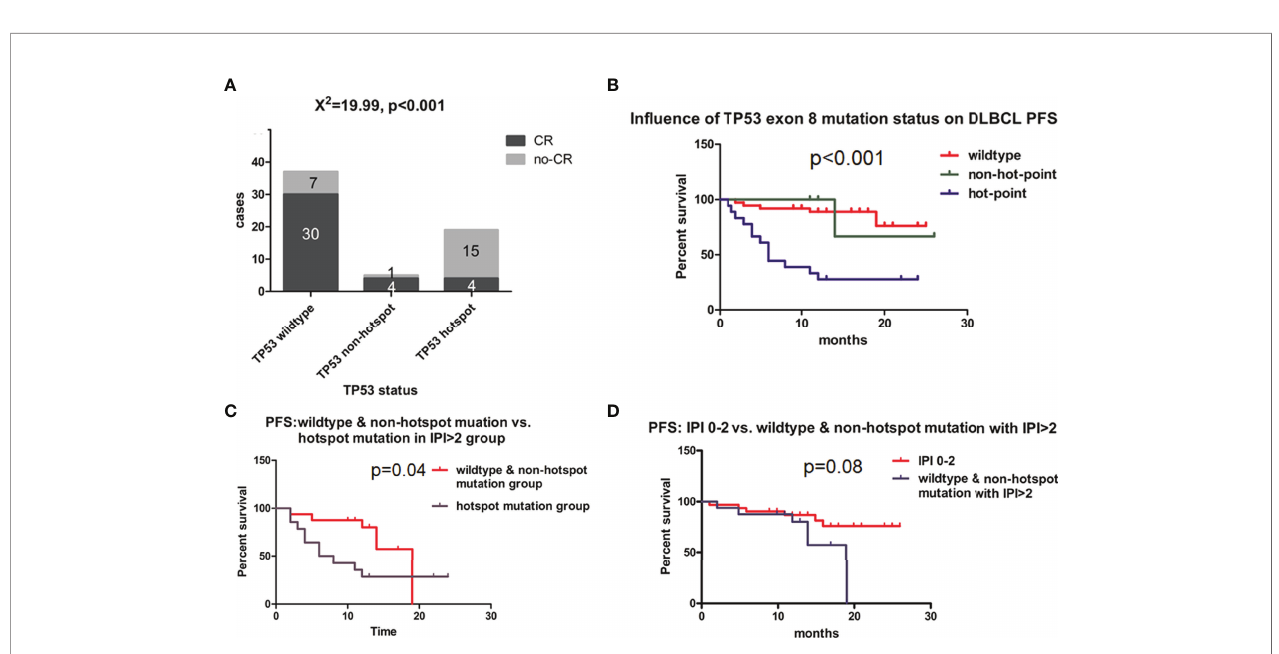
FIGURE 3 | Effect of TP53 exon 8 mutation on the clinical outcome of DLBCL patients. (A) CR rates in different groups based on TP53 status. CR status was evaluated by positron emission tomography – computed tomography scanning according to Lugano response criteria for non-Hodgkin ’ s lymphoma. Differences between groups of patients were assessed with the maximum likelihood chi-squared test. (B) PFS of different TP53 status groups. (C) PFS of IPI >2 group; patients with TP53 hotspot mutations, wild-type TP53 , and non-hotspot TP53 mutations were compared. (D) Comparison of PFS between IPI 0 – 2 and IPI >2 groups with wild-type TP53 and non-hotspot TP53 mutations. Patients were followed up for 12 months until disease progression, relapse, or end of observation. PFS was de fi ned as time to disease progression, relapse, or death, and was estimated with the Kaplan – Meier method and compared with the log-rank